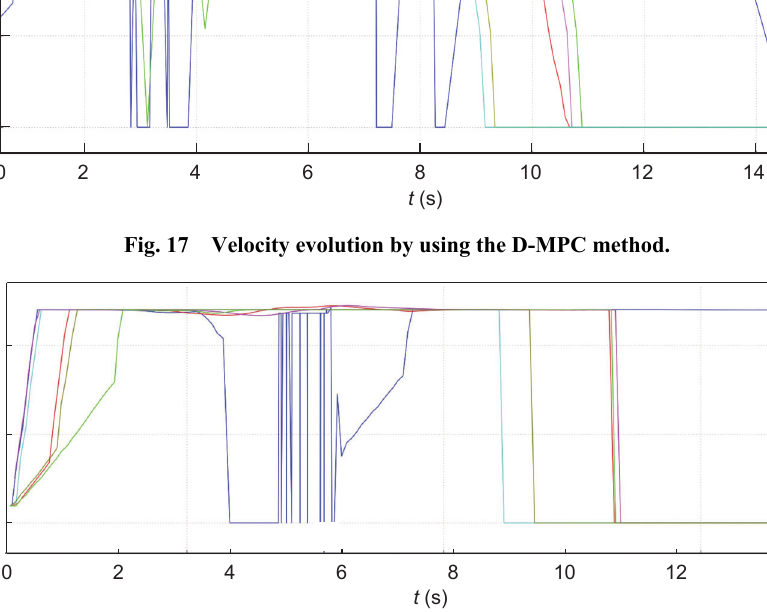
Fig. 18 Velocity evolution by using the P-MPCC method.